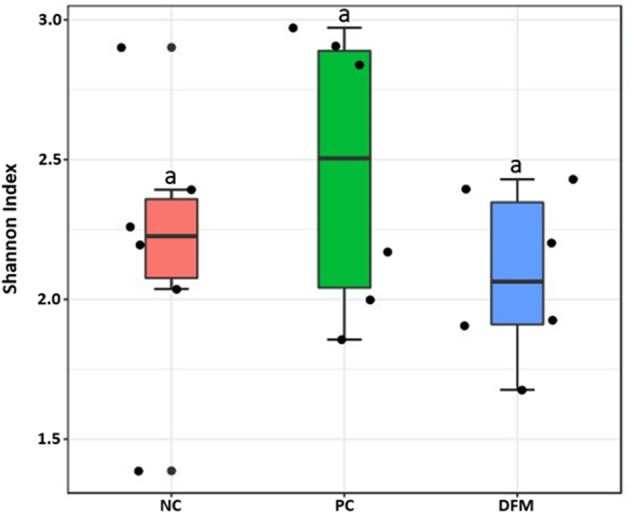
Alpha diversity of the three different groups (NC, PC, and the DFM group) as measured by Shannon Index. No significant difference was observed among three groups (ANOVA, p > 0.05).